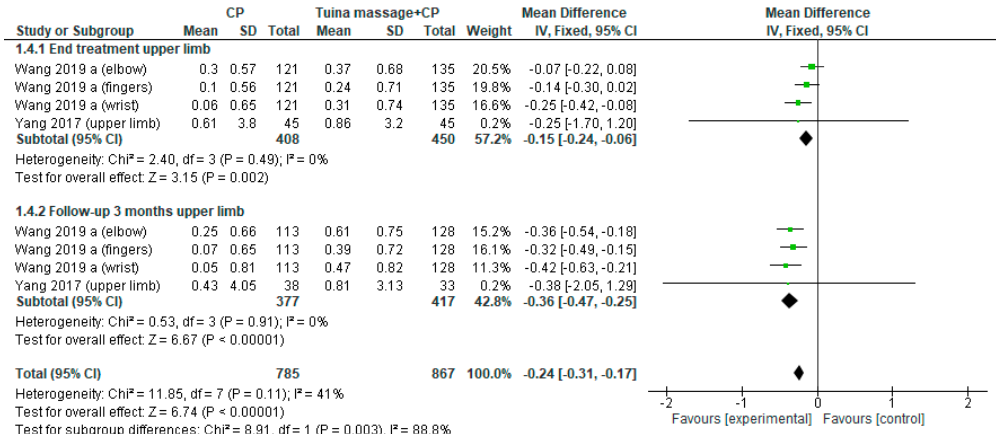
Figure 6. Forest plot of comparison Tuina massage plus conventional physiotherapy (CP) versus CP for upper limb spasticity in subacute stage ( ≤ 3 months) evaluated by modified Ashworth Scale.